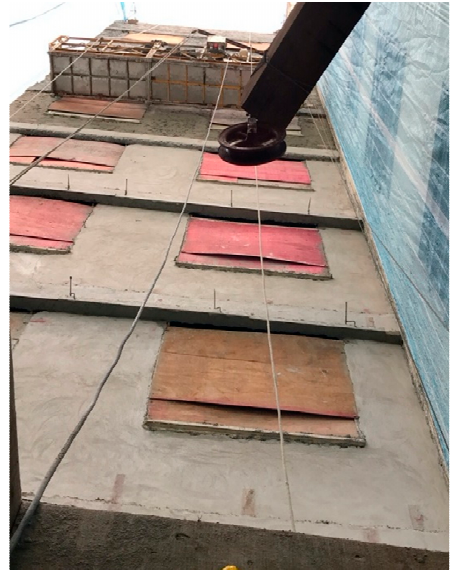
Figure 6. Complete application of a new rendering.